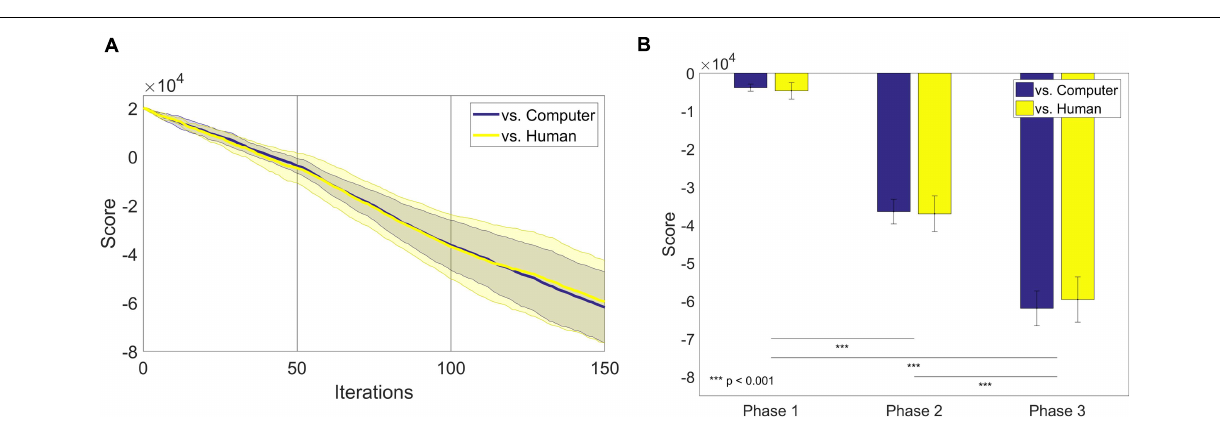
FIGURE 4 | (A) The average scores over one hundred fifty iterations in each group: computer-opponent (blue) and human-opponent (yellow). The shadings denote the standard error of mean. The initial score was given as 20,000. (B) The average scores earned by participants after the last iteration of each